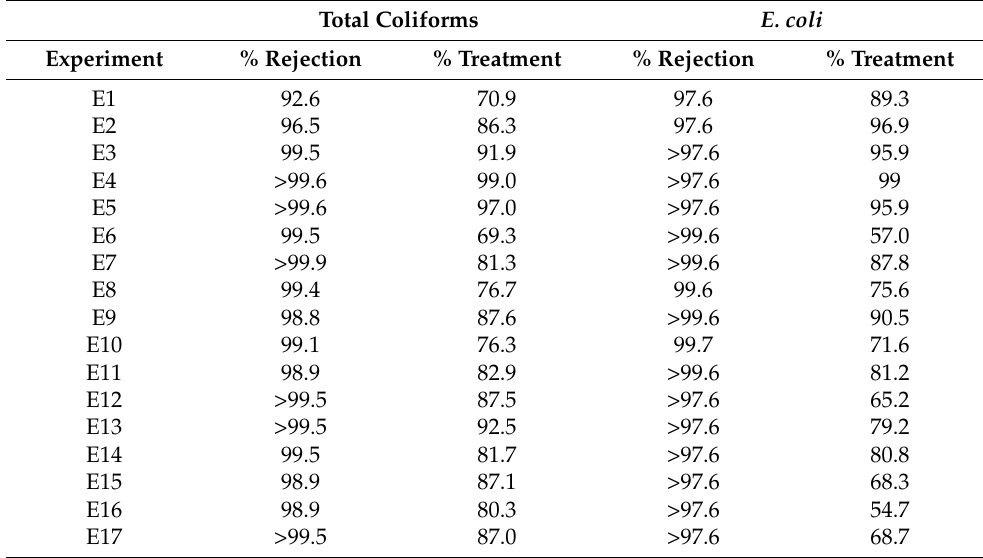
Table 4. Percent rejection and treatment of each membrane for the target bacteria. Total Coliforms E.